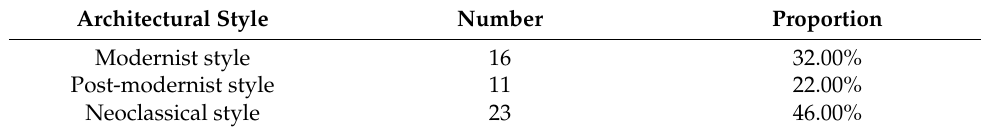
Table 1. The statistics of architectural styles of Chinese courthouse